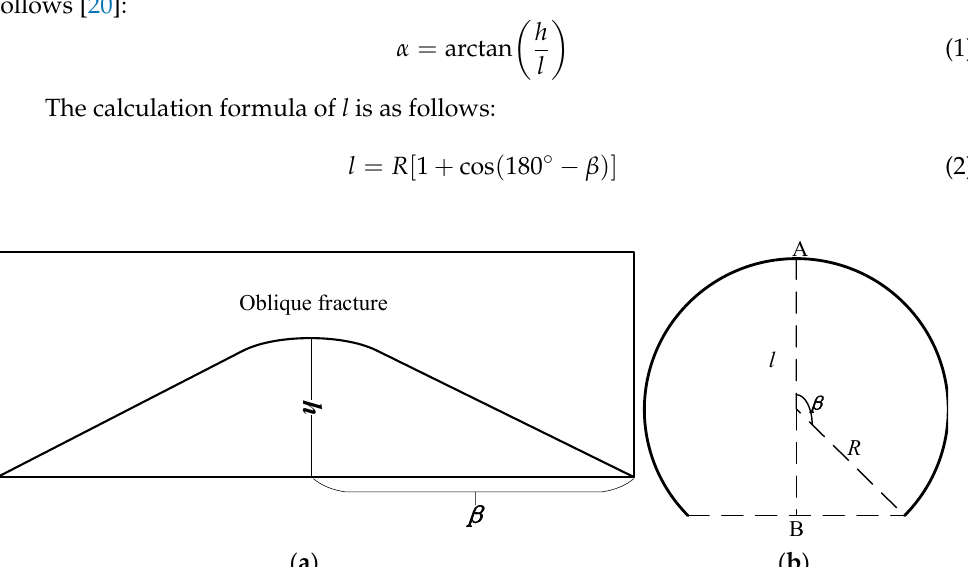
Figure 25. Echo amplitude imaging for the simulated borehole.